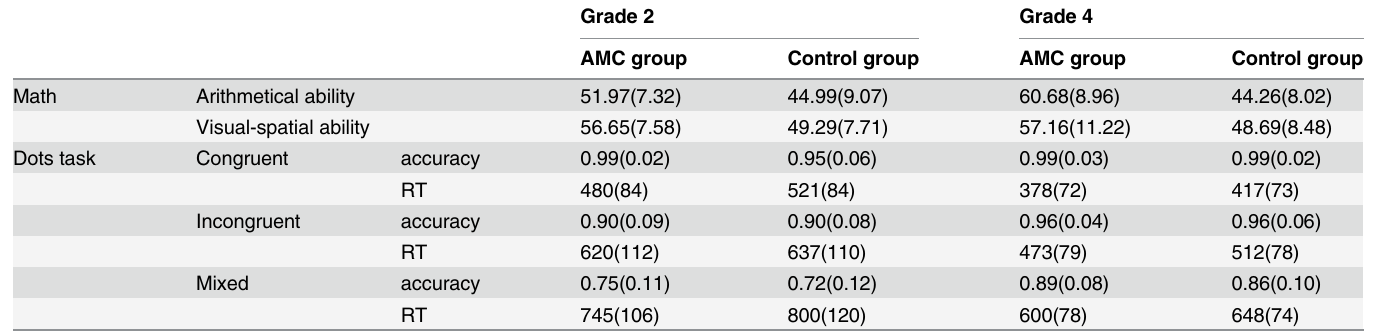
Table 2. Performance in math test and Dots task for both groups.